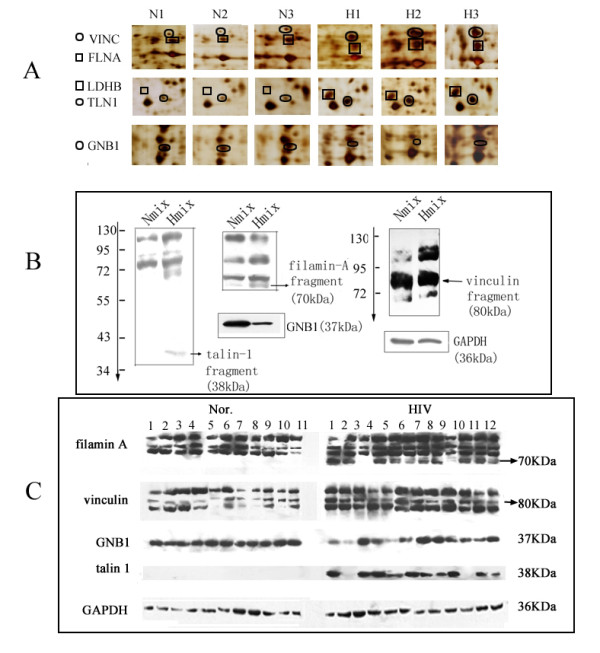
Western blotting verification of part of the differential proteins. A. Partially magnified images of five protein spots in 2D gels. B. Western blotting confirmation of talin-1, filamin-A, vinculin and GNB1 in pooled samples. C. Western blotting of GNB1, talin-1, vinculin and filamin-A in 23 individuals (12 from patients and 11 from healthy controls). GAPDH was used as the internal control.